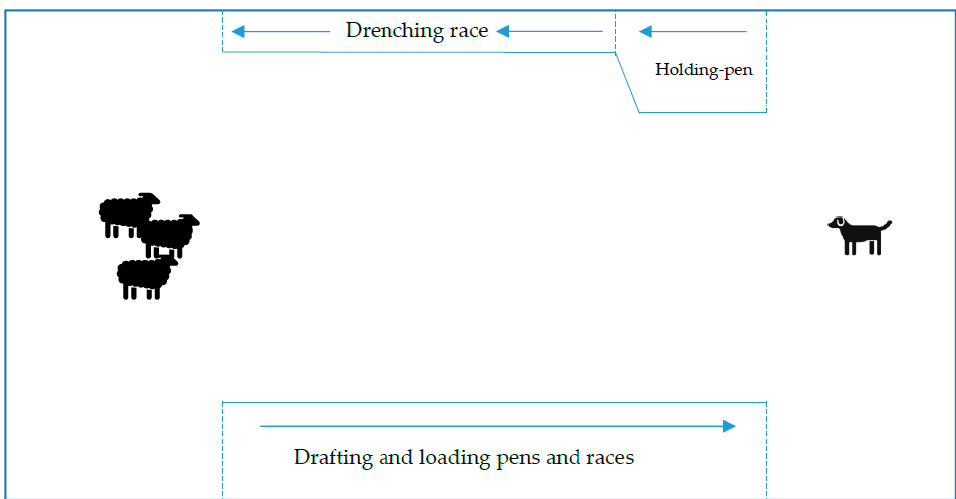
Figure 1. Diagram of competition yard course (not to scale). Illustration of standardised competition yard course. Dog graphic—starting point of dog for competition and video recording coding; Sheep graphic—starting point of sheep for competition and video recording coding; Holding-pen—first holding pen along competition course and end of video recording coding when last sheep entered. Drenching race—commonly used to administer veterinary therapeutics. Solid lines—yard fences; Broken lines—gates. The drafting (commonly used to separate selected sheep from the main flock) and loading pens and races (used to load sheep onto transport vehicles) section of this competition course were excluded from video recording coding. Arrows indicate direction of movement in races.